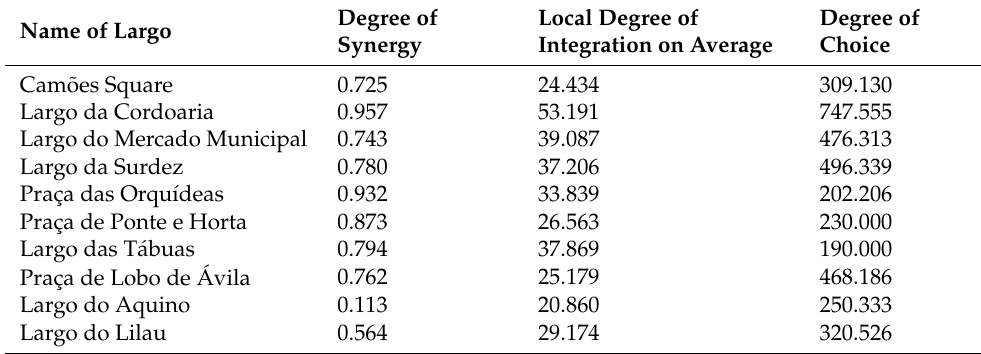
Table 2. Syntax parameters of community-related Largos.